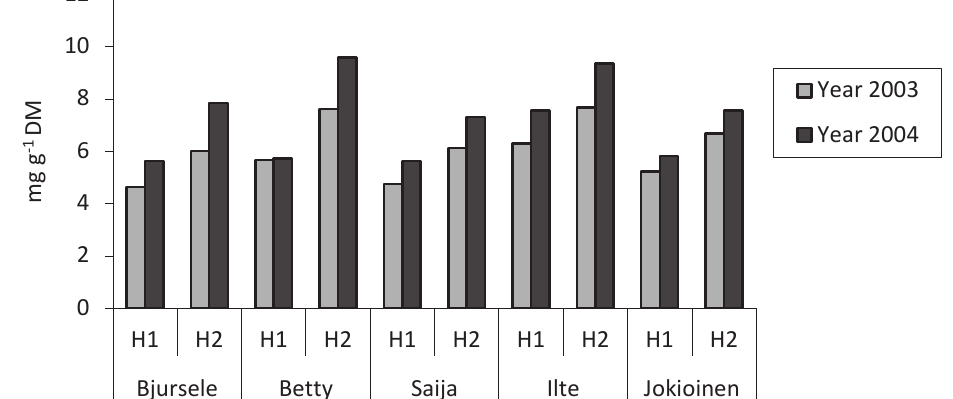
Fig. 2. The formononetin content (mg g -1 dry matter) for different red clover varieties at first (H1) and second (H2) harvest in 2003 and